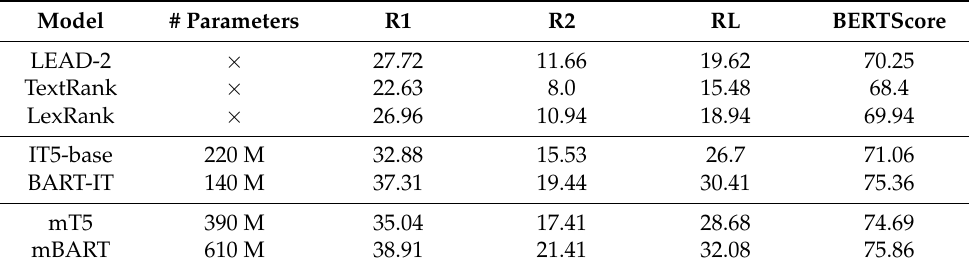
Table 4. Summarization evaluation results on the IlPost dataset. The # parameters column is empty for unsupervised baseline models since they do not include any trainable parameters.